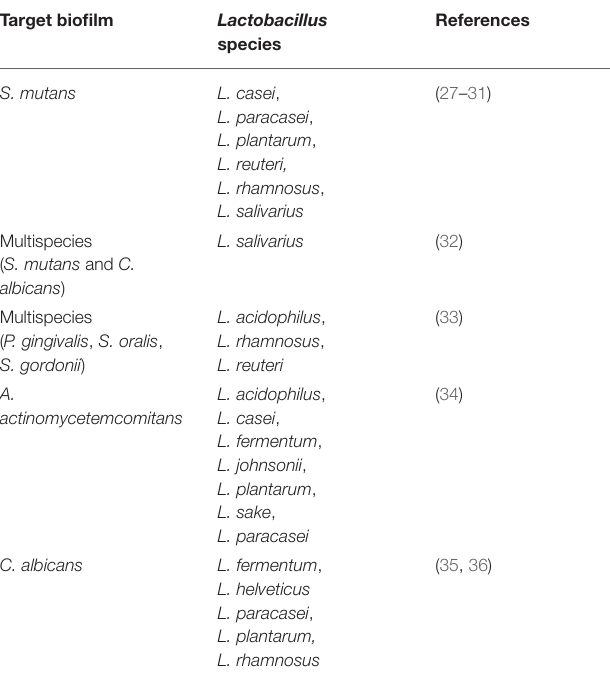
TABLE 1 | Probiotic Lactobacillus spp. exhibiting in vitro anti-biofilm activity against pathogens involved in oral biofilm-related